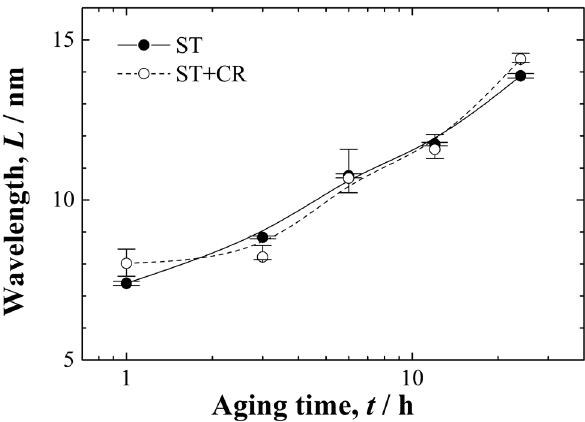
Fig. 5: Variations in the wavelength of compositional modulations accompanied by spinodal decomposition with aging at 723 K.